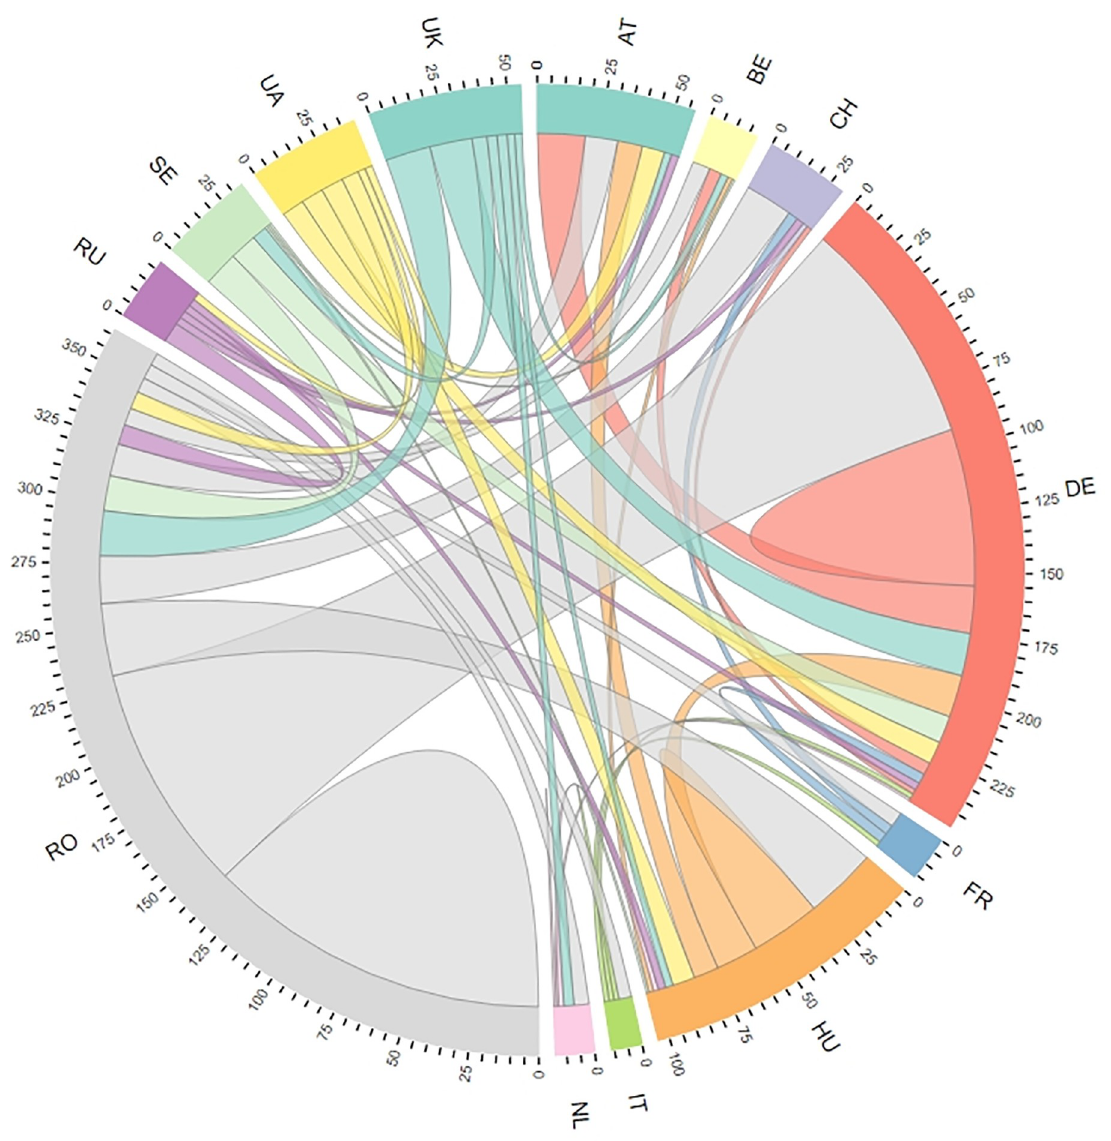
Fig 3. Collaborative patterns resulting from analyses of internationally visible publications related to grasslands in Romania. Links = co-occurring countries in an article; only countries with > 10 collaborations with institutions from Romania are shown.